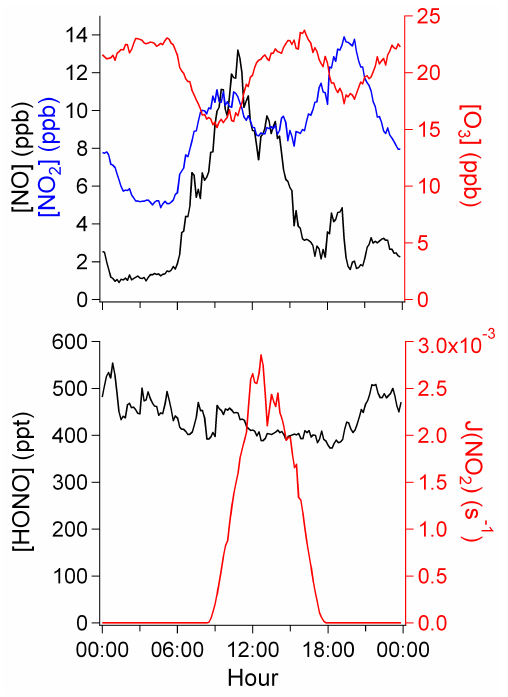
Fig. 4. Average diurnal 10min profiles for O 3 , NO x , HONO, and J (NO 2 ) during the MEGAPOLI winter campaign (local time).